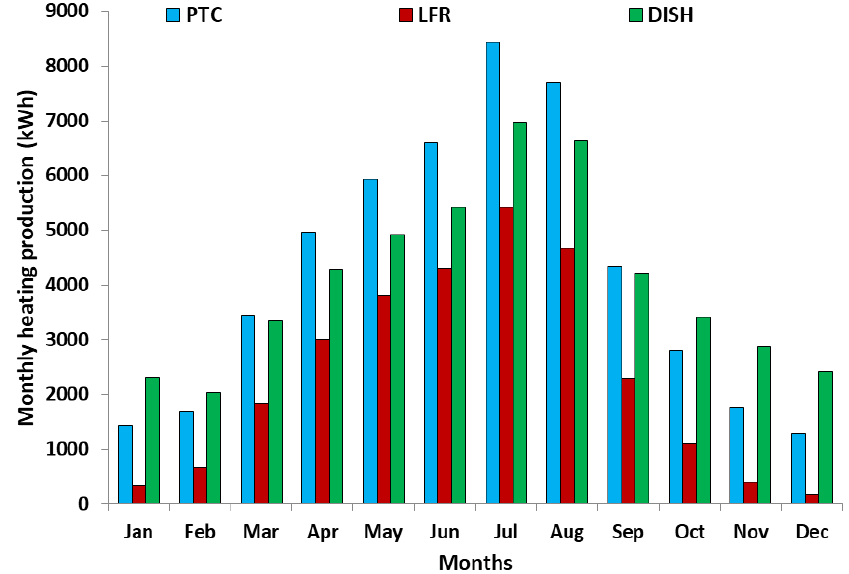
Figure 10. Monthly heating production for the three solar collectors.